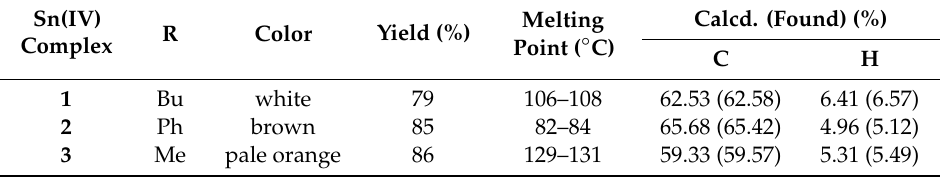
Figure 1. Synthesis of Sn(IV) complexes 1 – 3 . Table 1. Physical properties and elemental analysis of Sn(IV) complexes 1 – 3 .